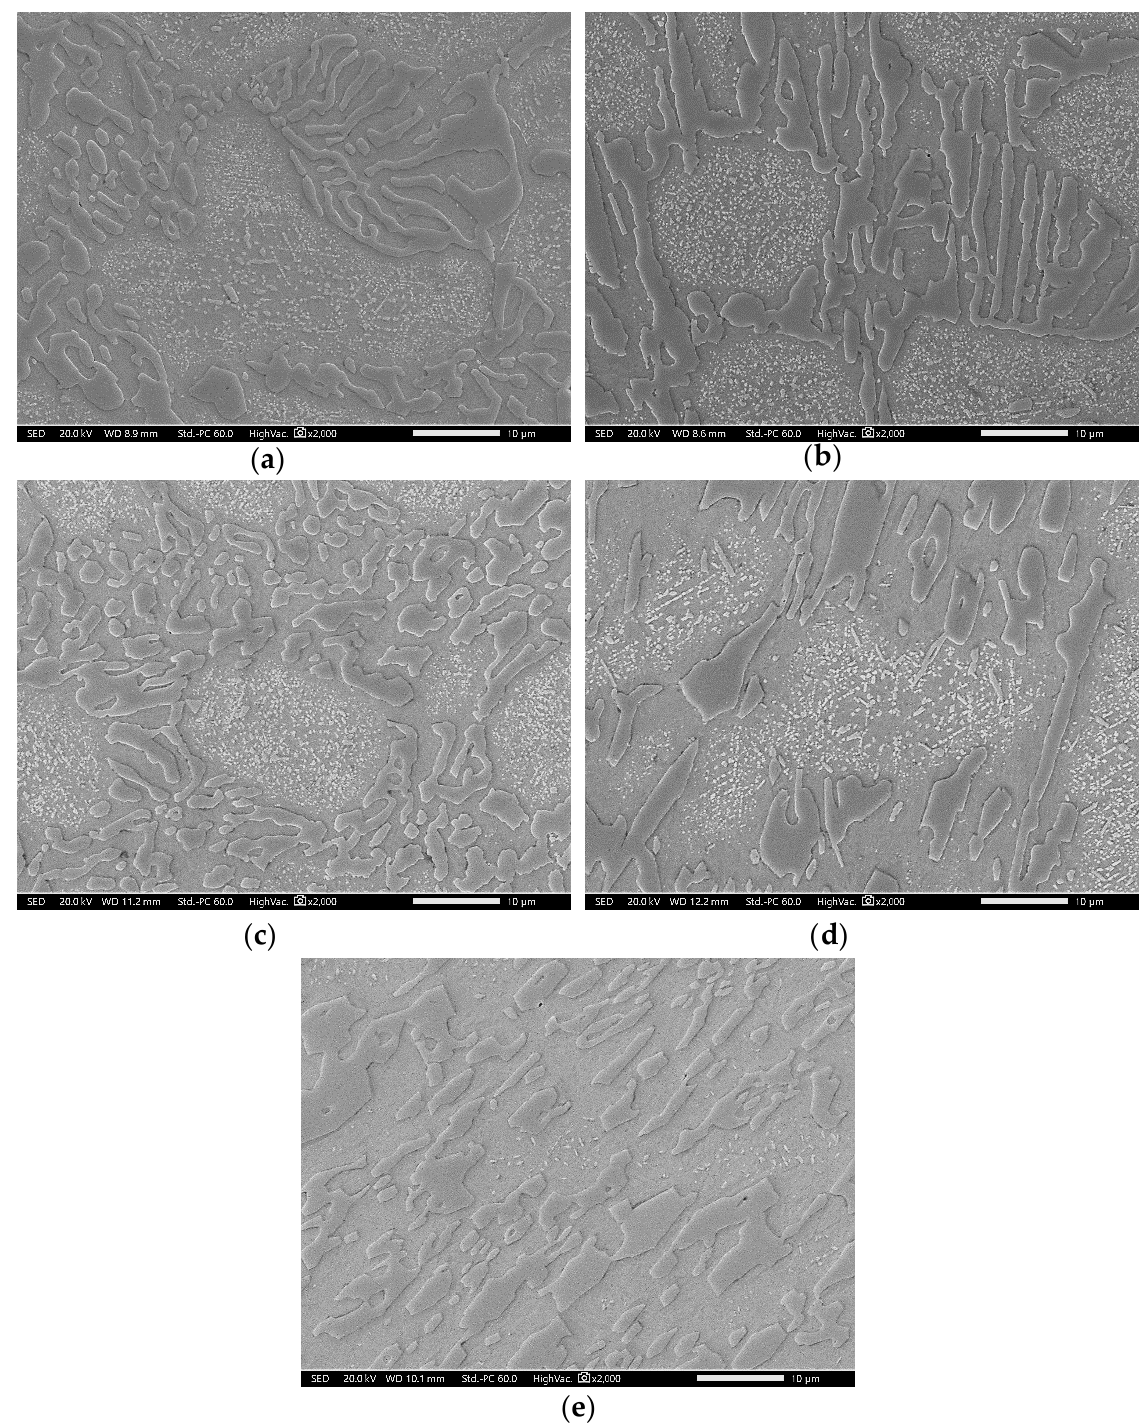
Figure 8. Micrographs of DES + AC + Temp-treated alloys showing similar to those in the conventionally heat-treated alloys: ( a ) 2124; ( b ) 2127; ( c ) 2427; ( d ) 2827; ( e ) 2927.